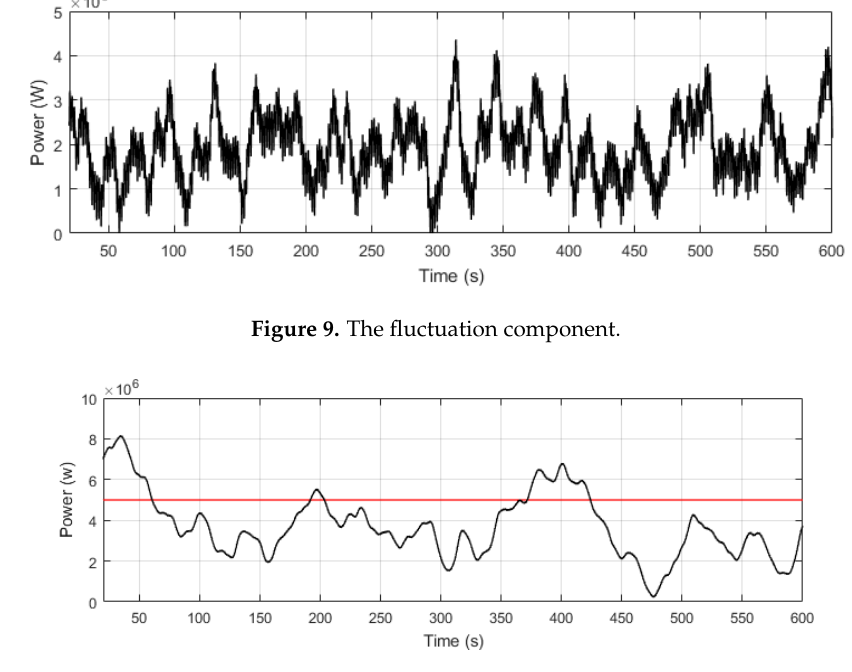
Figure 10. The output power after mitigation and TSO order.